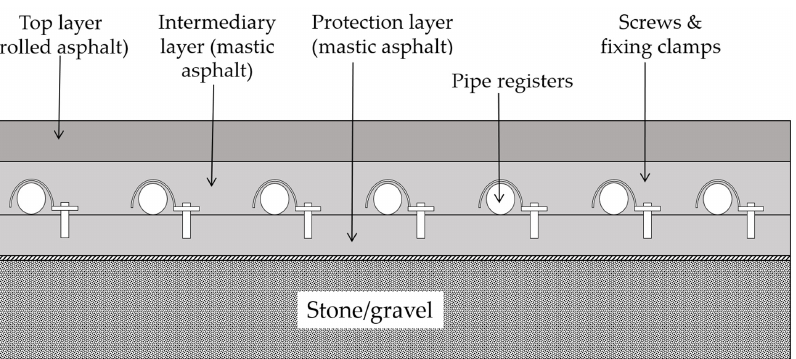
Figure 3. Cross-sectional layout of the road structure showing the three different asphalt layers.